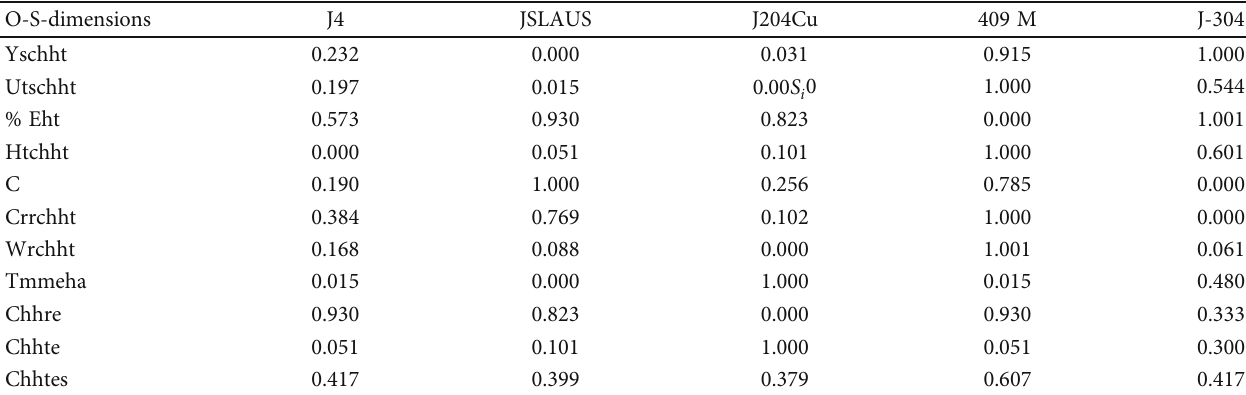
Table 8: Computed values of linking TEHES-O-S-tube material dimensions for assessing EAI.